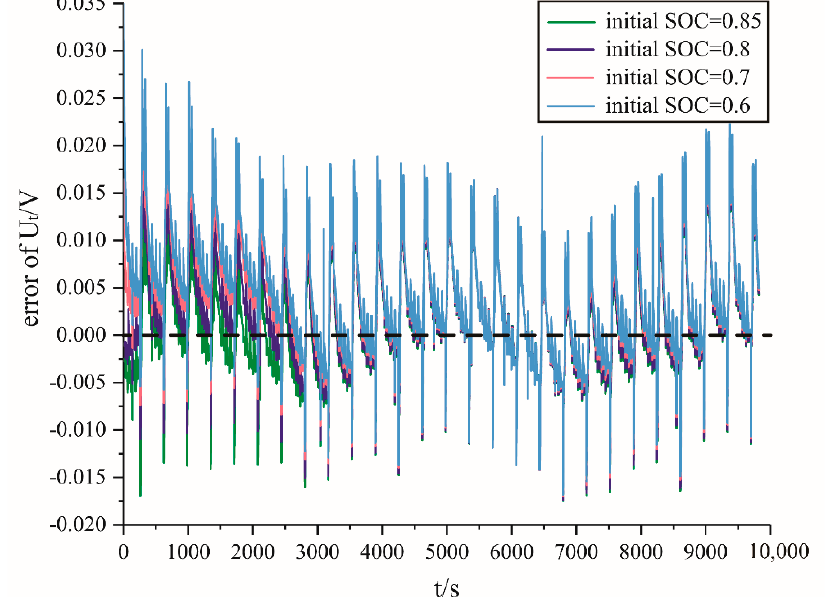
Figure 24. Comparison of terminal voltage errors filtered by FEKF in different SOC initial errors under 26 continuous DST conditions at 28 °C.